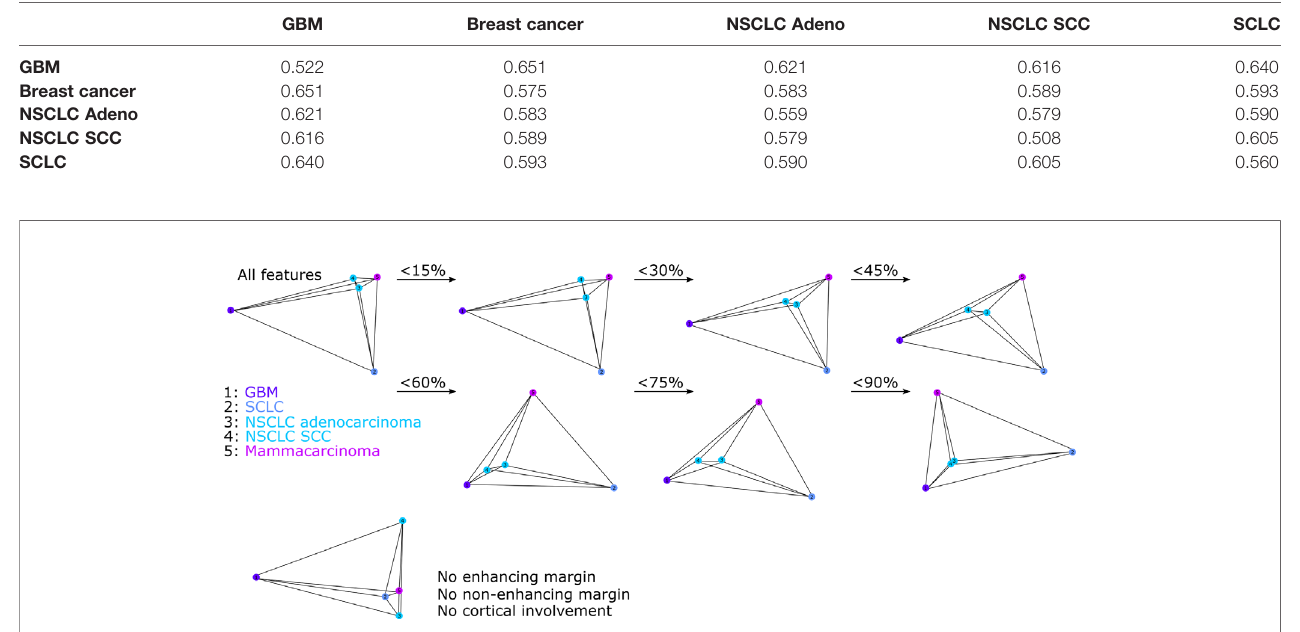
TABLE 2 | Mean Jaccard distance summarized for all lesions of a particular tumor type based on binary VASARI feature vectors (using the 15% threshold for exclusion).